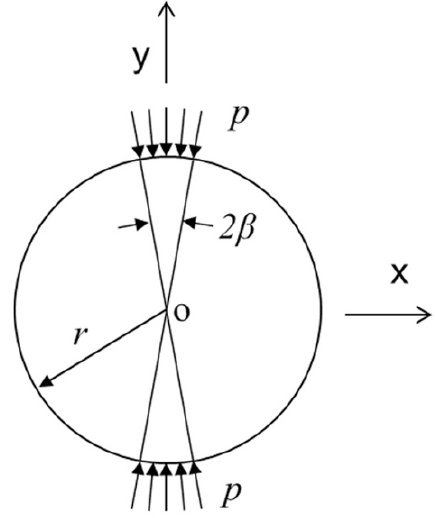
Figure 6. The Brazilian disc test using distributed load [27, 28].